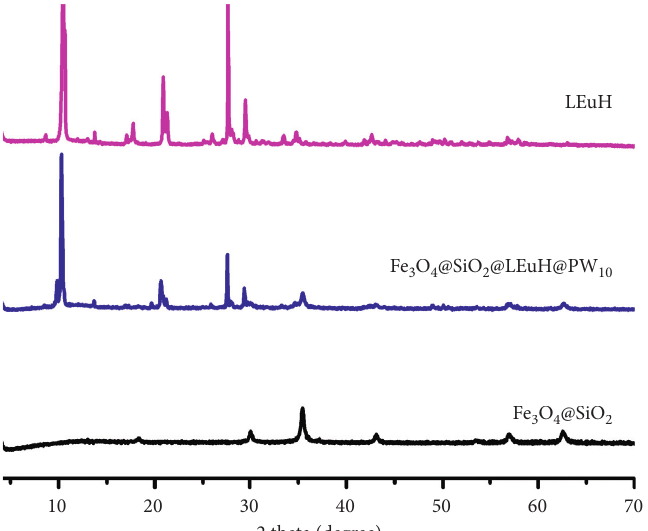
Figure 8: XRD patterns of the synthesized Fe 3 O 4 @SiO 2 @LEuH@PW 10 nanocomposite material in comparison with starting